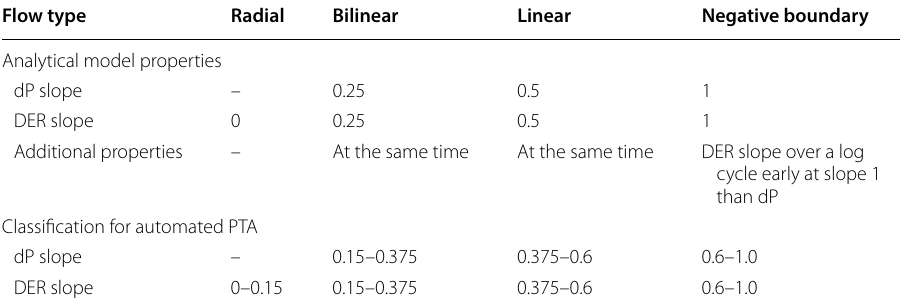
Table 2 Characteristic properties of the flow regimes of interest; analytical model versus classification for real-world parameter